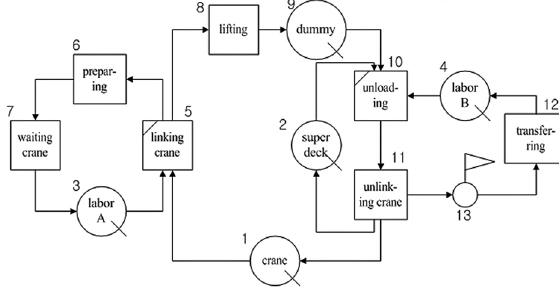
Fig. 3. Initial simulation model for the lifting process